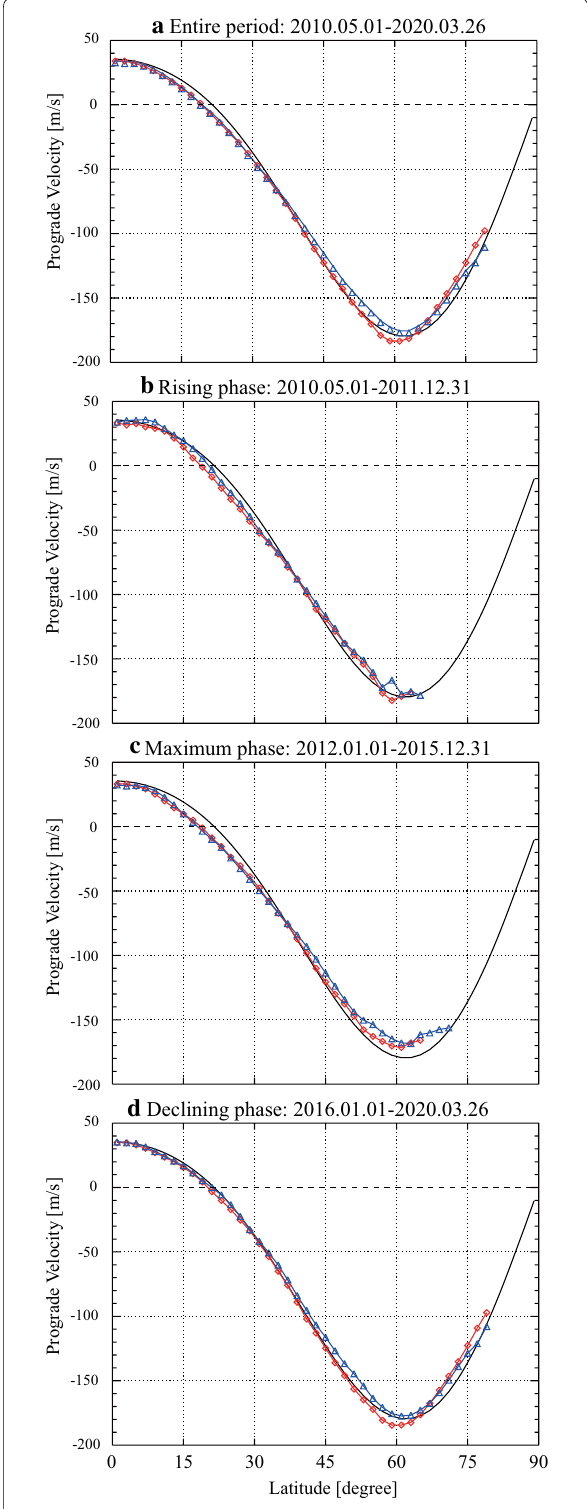
Fig. 2 Average differential rotation speed profile in the northern (red) and southern (southern) hemispheres a during the entire period, b rising, c maximum, and d declining phases of solar cycle